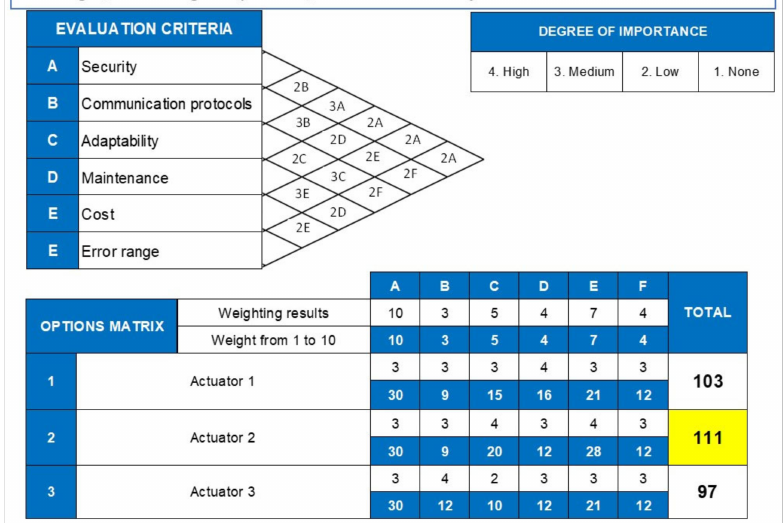
Figure 4. Evaluation matrix for the actuators. Yellow Highlight: This is to highlight the highest score achieved in the technical